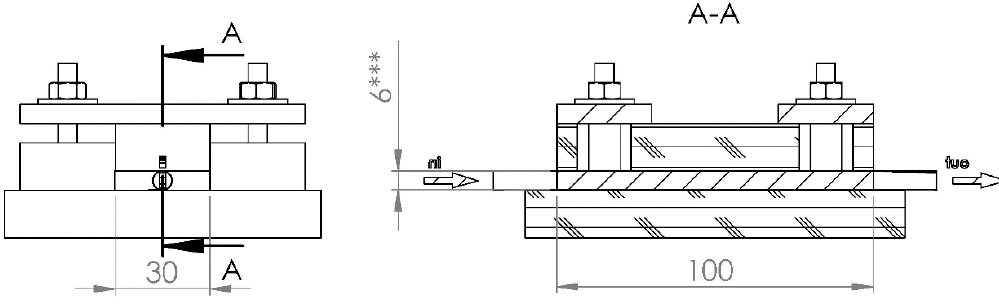
Figure 3. Dimensions of experimental cell.